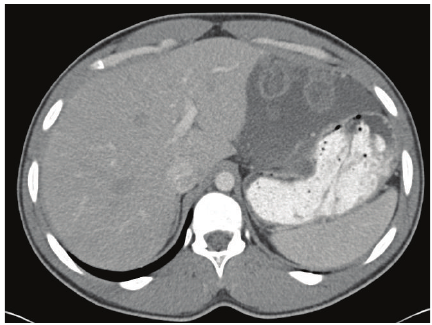
Figure 1: Computed tomography (CT) image demonstrating the appearance of gastric GIST after seven months of treatment with imatinib 400mg per day; the tumor is unchanged in size compared to initial presentation (initial CT not shown).